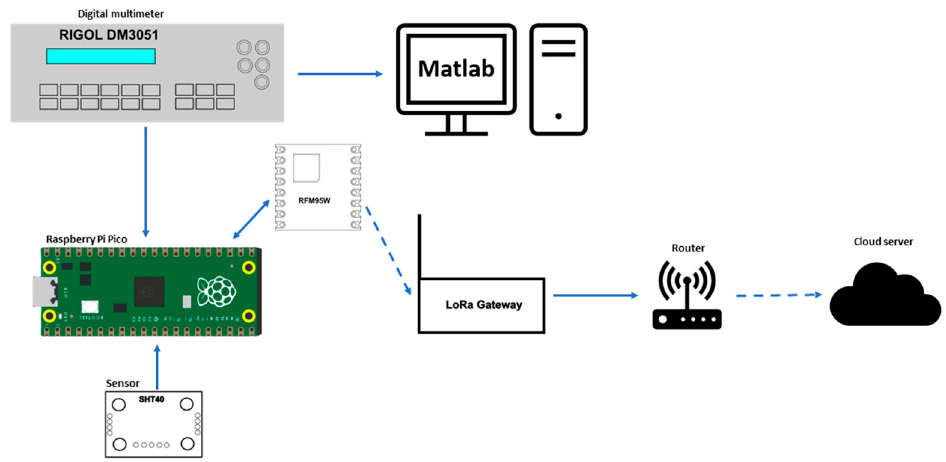
Figure 5. The architecture of the communication system and measuring equipment (own source).